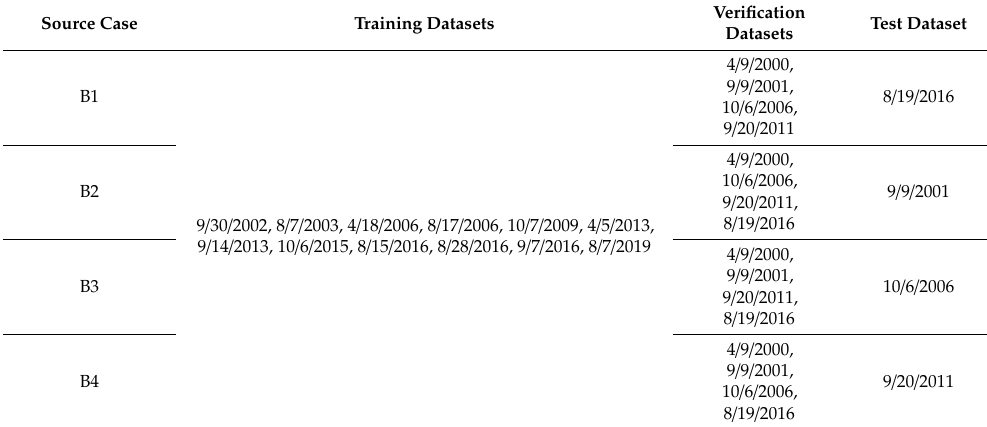
Table 5. Target datasets for training, validation, and testing in Domain